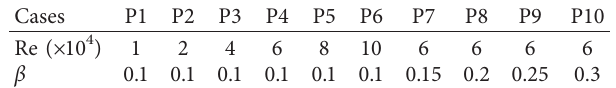
Table 3: Simulation cases for plane wall jet. Cases